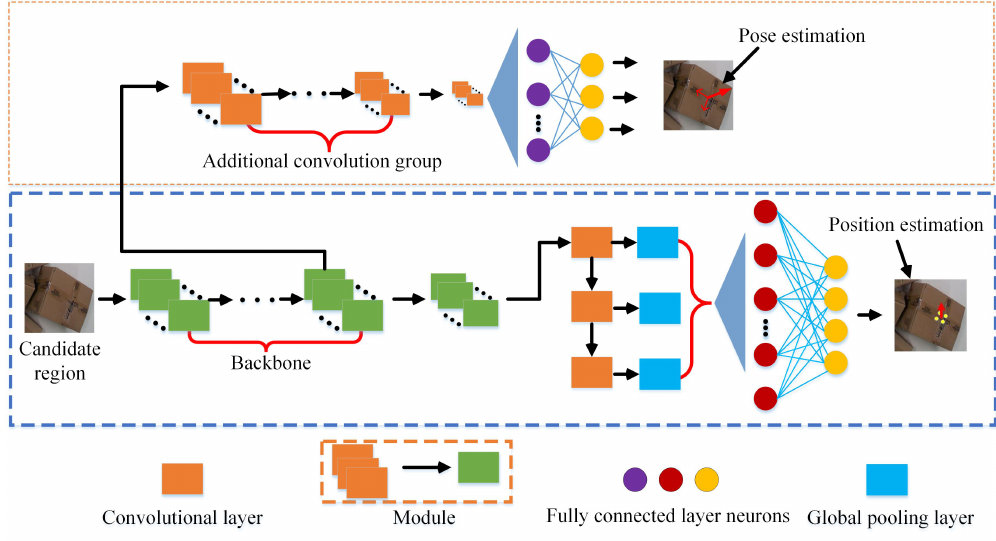
Figure 7. Optimal multi-task sorting position and pose estimation network